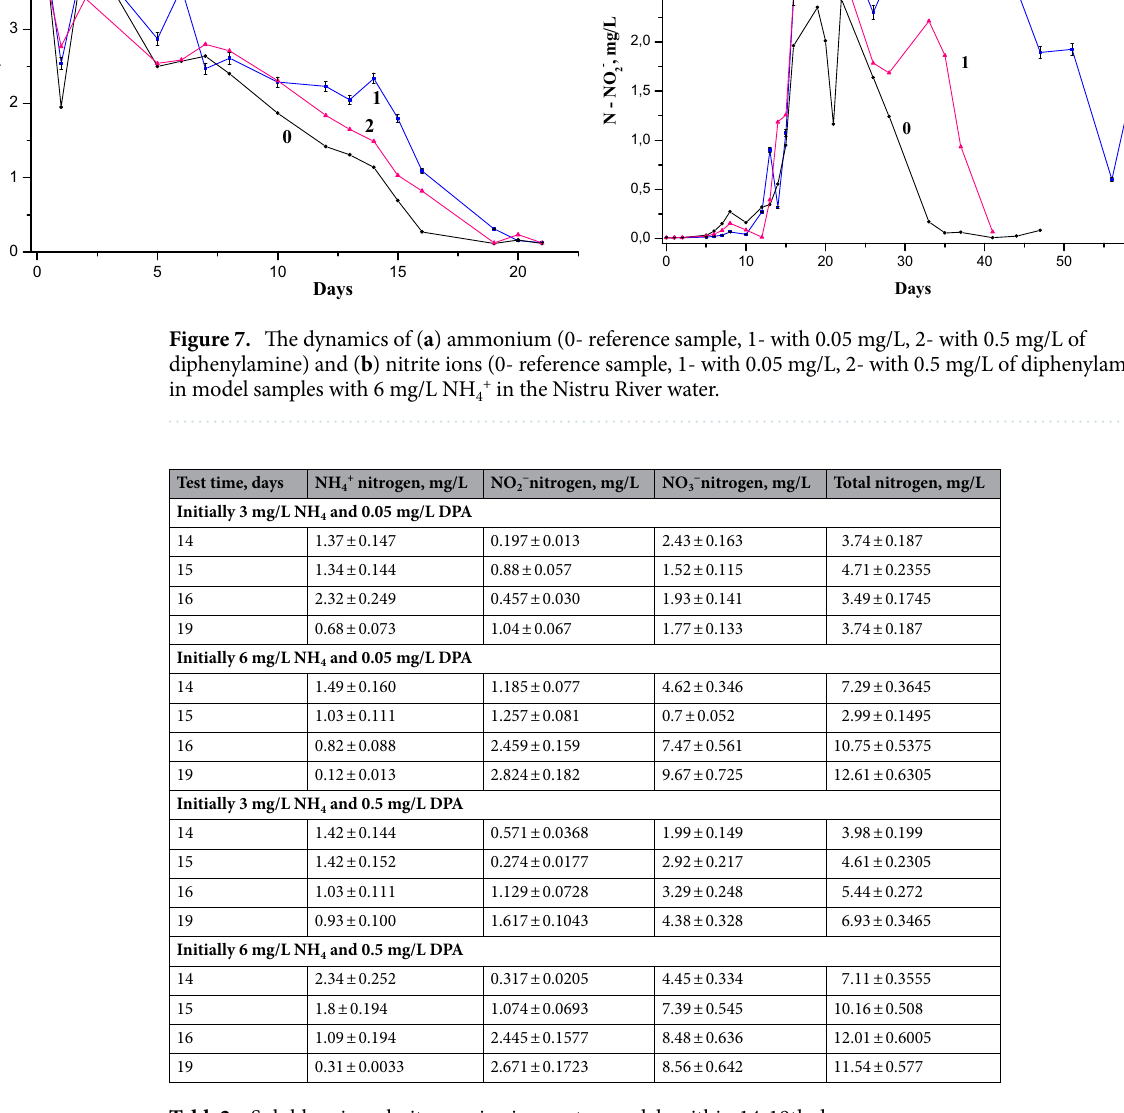
Table2. Soluble mineral nitrogen in river water models within 14-19th